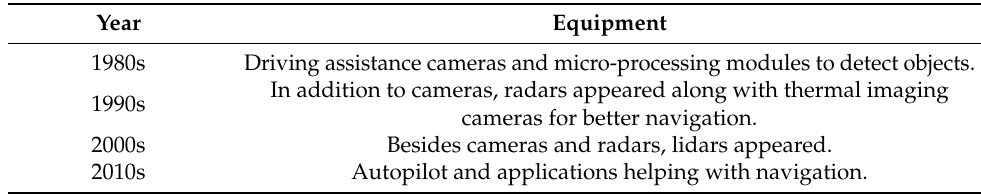
Table 6. Evolution of autonomous vehicle equipment